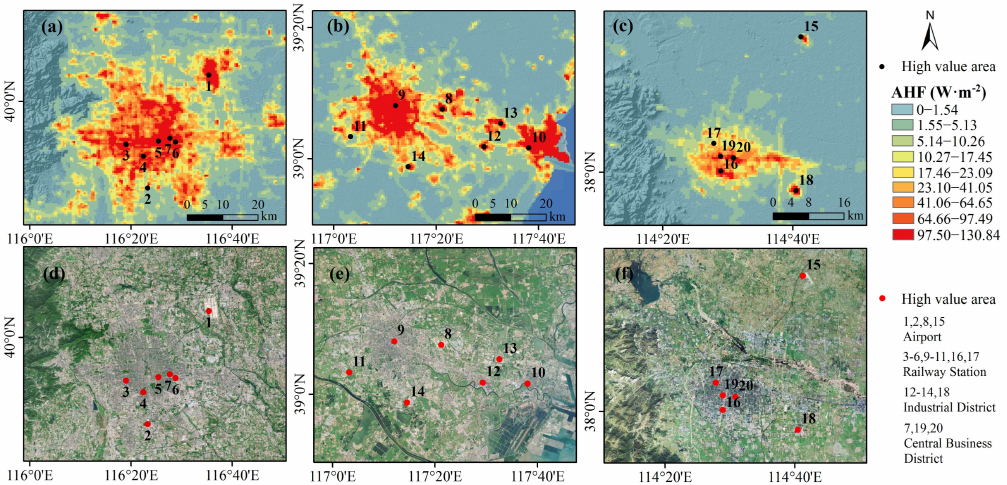
Figure 6. RAHF results for typical cities in the Beijing–Tianjin–Hebei region and the validation of the high value area distribution (( a ) AHF results for Beijing city; ( b ) AHF results for Tianjin city; ( c ) AHF results for Shijiazhuang city; ( d – f ) The corresponding high-resolution remote sensing images from Google Earth).